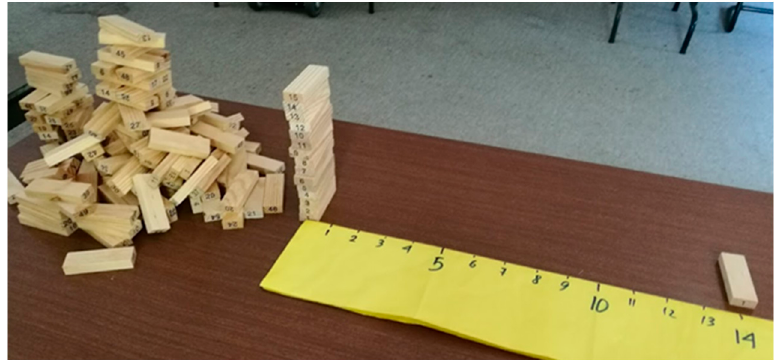
Figure 5. At the left of the image, a pile of blocks representing the unknown number of infected people on day 0 for each person that dies on 14th day.